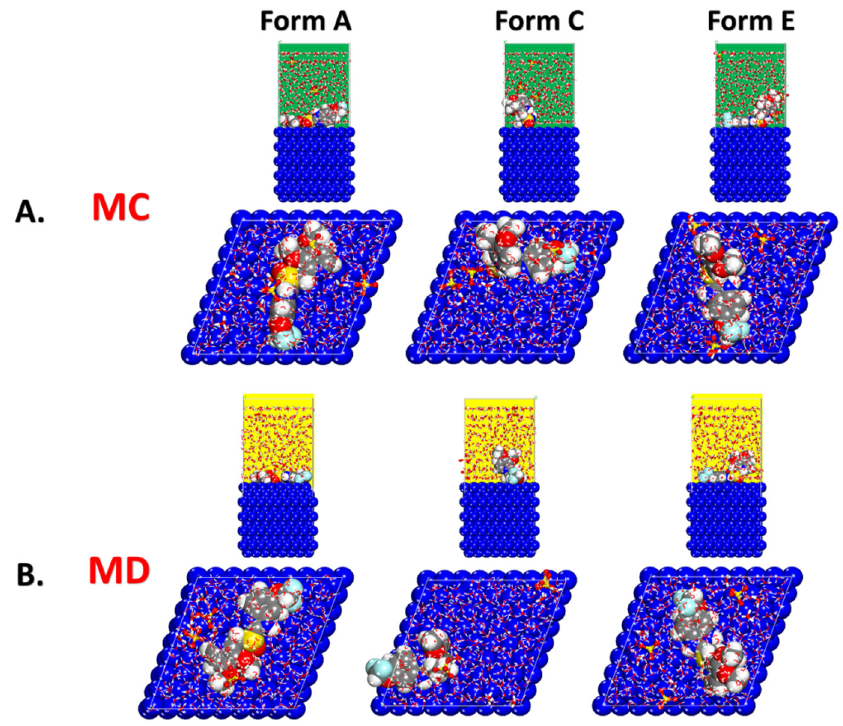
Figure 5. ( A ) MC and ( B ) MD obtained from the adsorption configurations of the different protonated forms of the Pantoprazole inhibitor in the simulated corrosion media on the Fe surface.